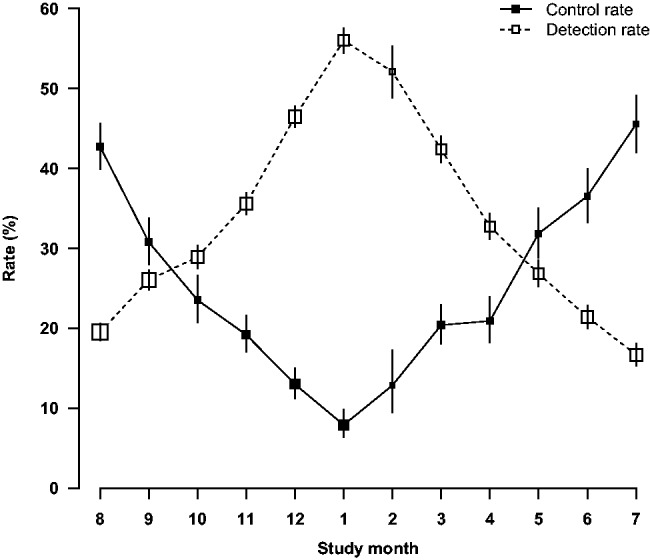
Detection and control rates of hypertension by study month. Rates were adjusted for age, sex and education, and plotted by the mean dates of survey in that month. The detection/control rates and 95% CIs are shown in open/solid squares and vertical lines. Sizes of squares are inversely proportional to the standard errors of the point estimates.